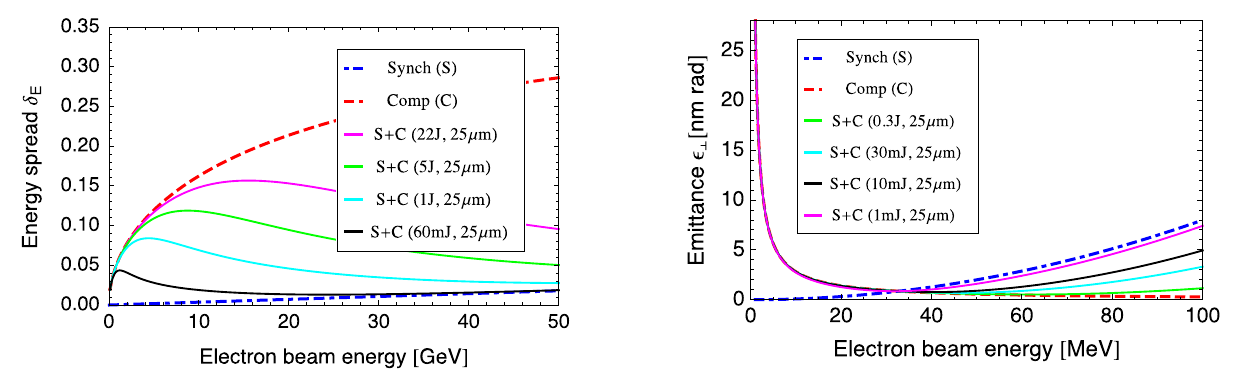
FIG. 4. Compton ring relative energy spread. The natural energy spread ( “ Synch ” ) is calculated for an isomagnetic ring with magnetic radius of 5.37 m. A 1 μ m wavelength laser is used for estimating the Compton induced energy spread ( “ Comp ” ). The final equilibrium energy spread ( “ S þ C ” ) is given for four different laser pulse energies and for the electron and laser beam ¼ 25 μ m. size of σ e;L